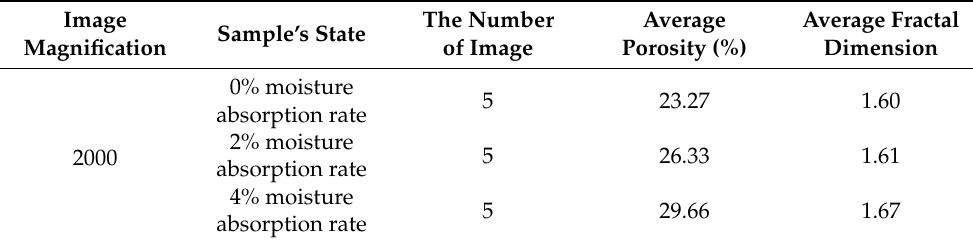
Table 5. Porosity and fractal dimension of the samples during gaseous water